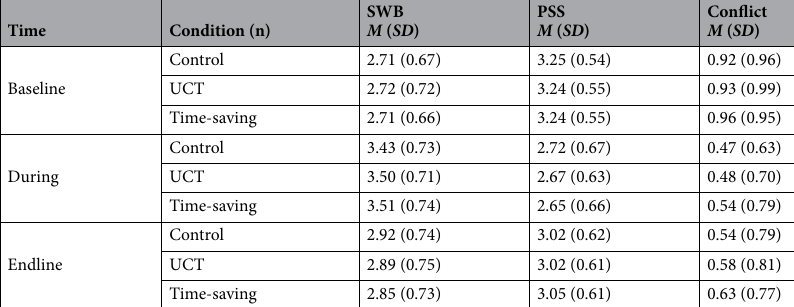
Table 3. Descriptive statistics by condition for subjective well-being (SWB), perceived stress (PSS), and relationship conflict at baseline (week 1), during the interventions (Weeks 3–5, weighted average), and at endline (Week 6). Reporting means and standard deviations for each condition at each time point: baseline (Week 1), during the intervention (weighted average of Weeks 3–5), and endline (Week 6). Outcome measures during the intervention were calculated as a weighted average of participants’ responses in Weeks 3, 4, and 5. For subjective well-being, the measure during the intervention was a weighted average of positive affect and negative affect in Weeks 3–5. The Satisfaction with Life Scale was not included in this measure because it required a visual aid and therefore was not administered during the intervention weeks via the phone survey. To be included, participants had to complete 1 or more phone surveys. Endline includes in-person endlines and endlines conducted via